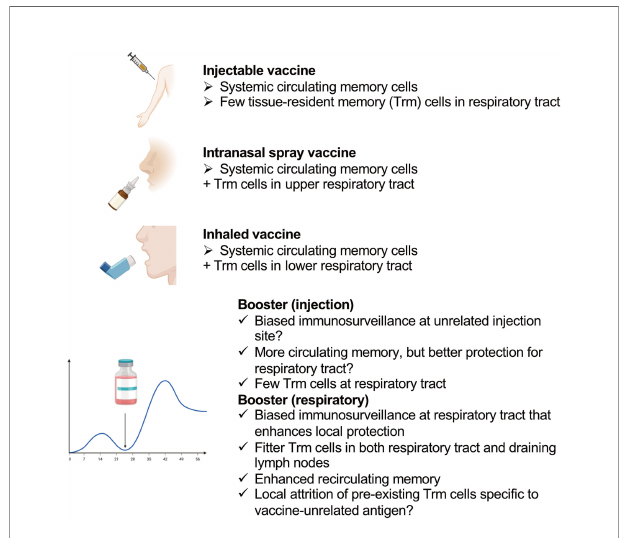
FIGURE 2 | Features of different types of vaccines that induce CD8 + T cells and the effects of different locations of